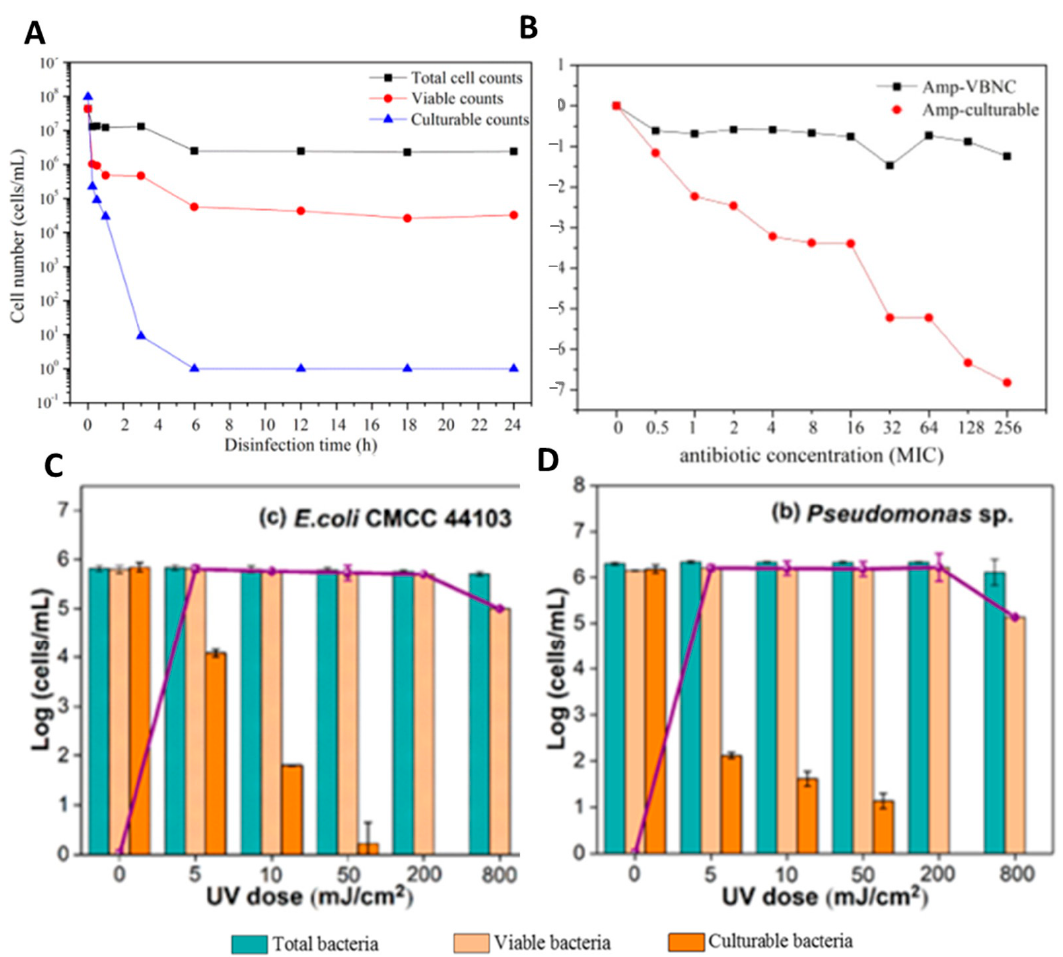
Figure 7. CTC flow cytometry used for tolerance testing of E.coli , adapted from [47,181]. ( A ) Entry of E. coli into the VBNC state on incubation by chlorination at the dosage of 0.5 mg/L free chlorine. Shown are total cell counts (black square), culturable counts (blue triangle), and viable counts (red circle). ( B ) Persistence of E. coli exposed to ampicillin. Black circles represent E. coli in the VBNC state, while red circles represent E. coli in the culturable state. ( C , D ) Total, viable, and culturable cell counts of E. coli ( C ) and Pseudomonas spp. ( D ) after the treatment by various UV fluences. The purple line represents the number of VBNC bacteria, determined as the difference between the number of viable and culturable cells.